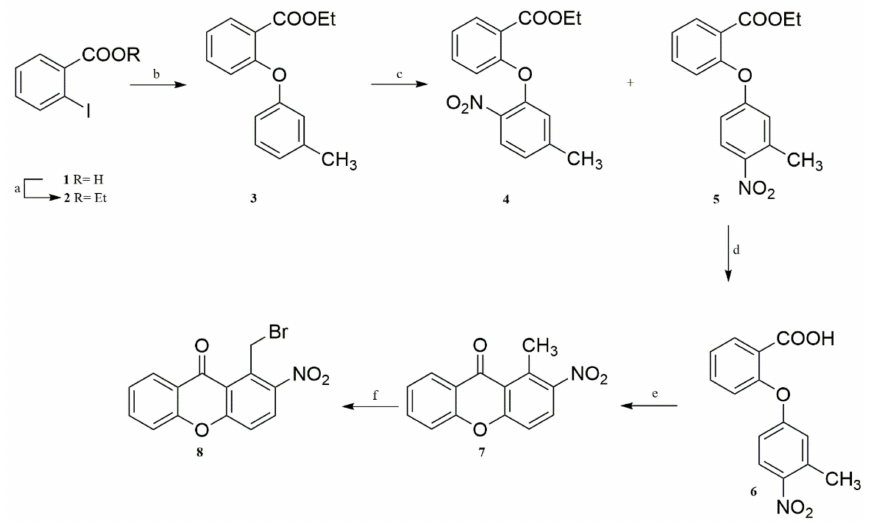
Figure 1. Synthesis of the derivatization reagent ( 8 ): Reagents and conditions: a: conc. H 2 SO 4 , abs. ethanol, reflux; b: m-cresol, CuCl, K 2 CO 3 , pyridine, reflux; c: fum. HNO 3 , (CH 3 CO) 2 O, 24 h, 0 ◦ C; d: 40 % NaOH, ethanol, rt; e: PPA, 100 ◦ C; f: NBS, dibenzoyl peroxide, CCl 4 , UV (80-W lamp), 8